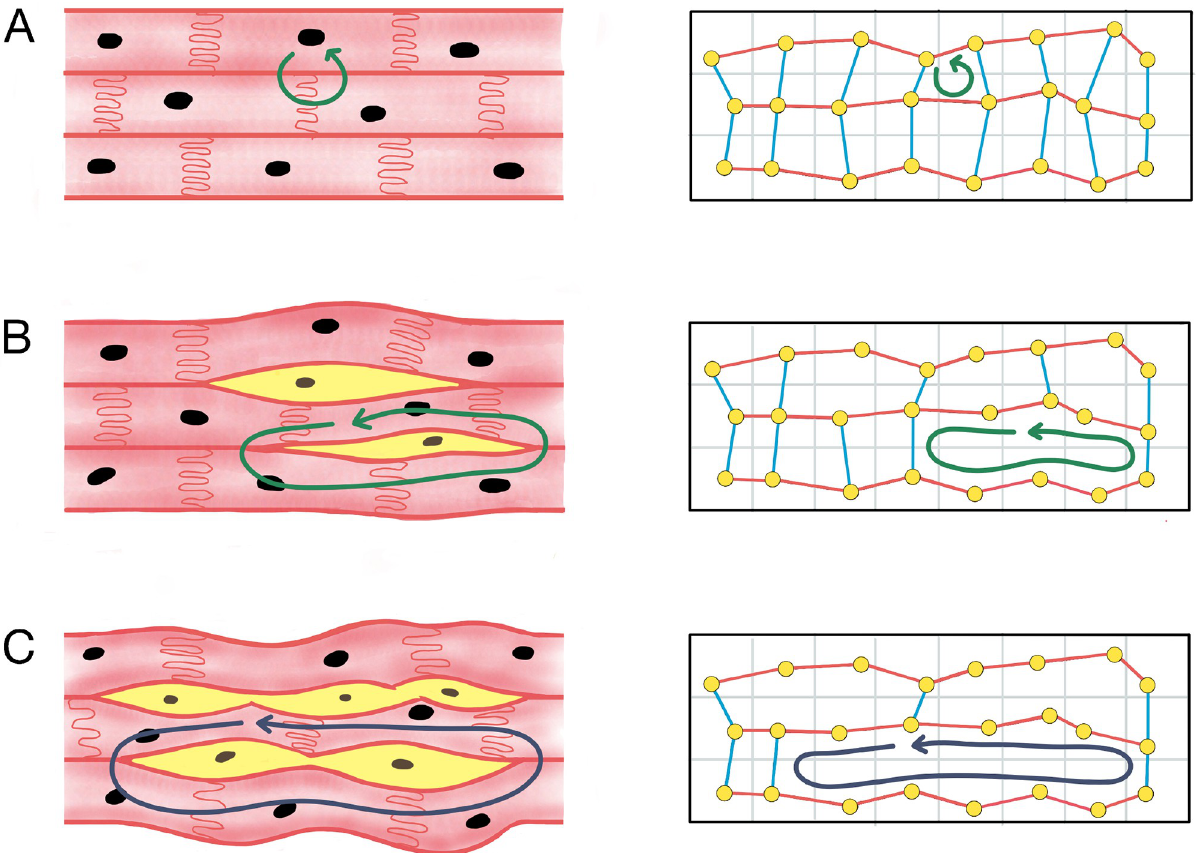
Fig 1. A schematic illustrating our approach. Left column: (A) In the healthy atrial myocardium, cardiomyocytes (pink cells) are well coupled along and across the principle fibre directions, such that the longest reentrant loop is too short to sustain micro-anatomical reentry (green arrows). (B) Over time, the atria accumulate interstitial fibrosis (yellow cells) forming short segments of electrically isolated fibre. (C) The length of these segments grows as more interstitial fibrosis accumulates until the isolated segments are sufficiently long to harbour micro-reentry (blue arrows). We hypothesise that the accumulation of interstitial fibrosis can be modelled as a spatial network. Right column: Nodes (yellow points) representing a group of cardiomyocytes are connected to their neighbours along fibres (red links) and across fibres (blue links). If the density of interstitial fibrosis is low, there are many transverse (blue) links. We model the increase in the density of interstitial fibrosis as the progressive removal of transverse links, and equate the micro-anatomical reentrant substrate to regions of the spatial network where a loop exists that is longer than one refractory wavelength.